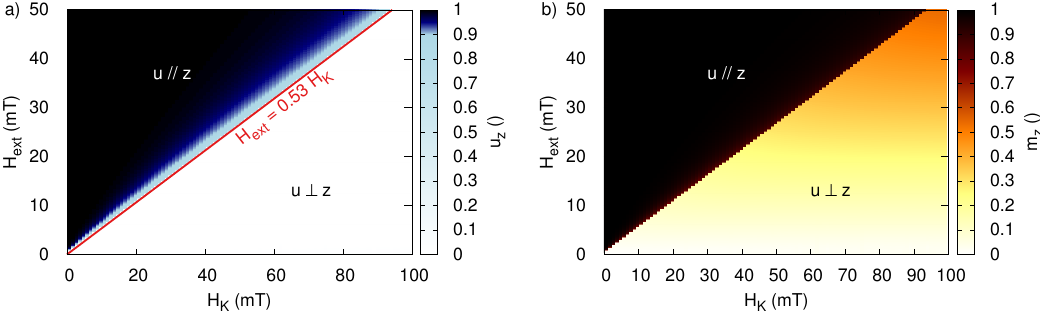
Figure 4. ( a ) The z-component of the anisotropy, averaged over one period, in dynamical equilibrium during the application of the sinusoidal time-varying field as function of the particle coercivity H K and the amplitude of H ext . ( b ) The z-component of the magnetization (i.e., the particles’ response) at the end of the time-varying field pulse.